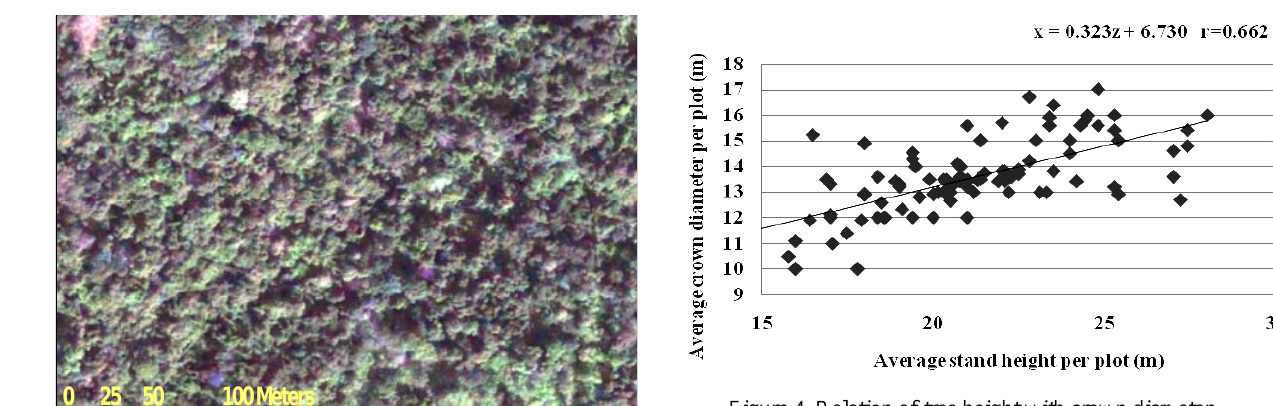
Figure 4. Relation of tree height with crown diameter